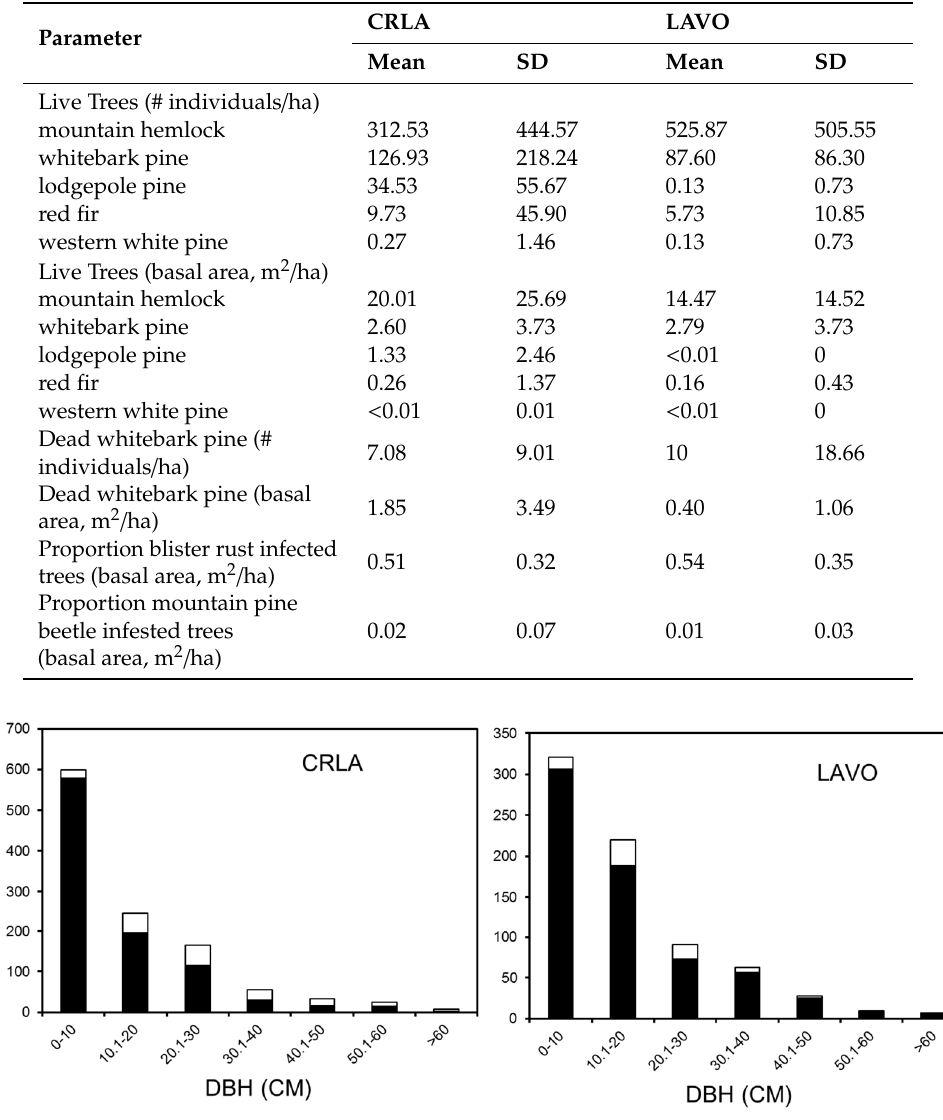
Table 2. Summary statistics of living and dead trees sampled in 30 plots in each of two parks Crater Lake (CRLA) and Lassen Volcanic (LAVO) National Parks. Mean values among plots ( n = 30) in each park and standard deviations (SD) are shown.